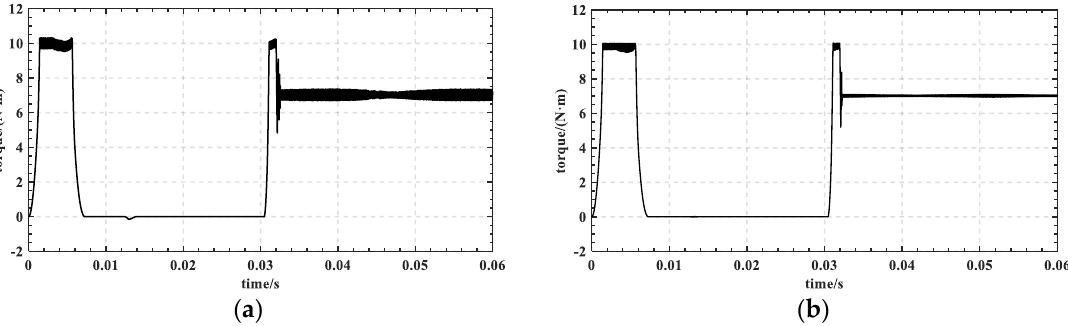
Figure 13. Torque comparison with 7 N load: ( a ) torque of PID control system and ( b ) torque of FNN control system.